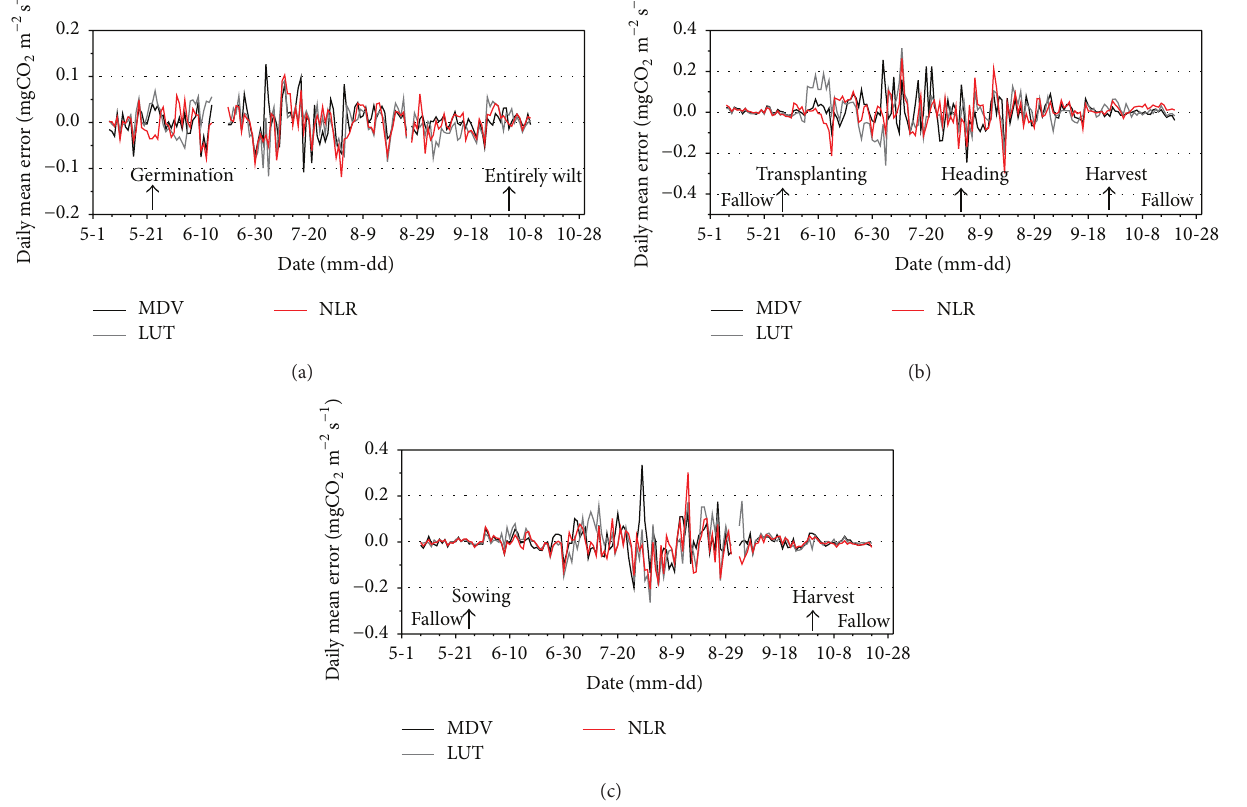
Table 4: Mean bias error of half-hourly 𝐹